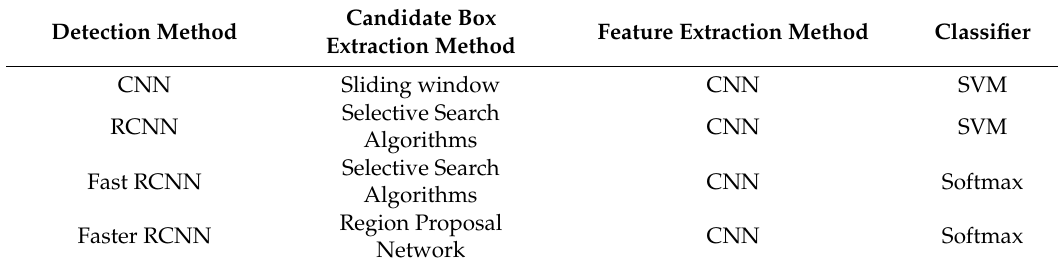
Table 1. Features of the various vehicle detection methods.